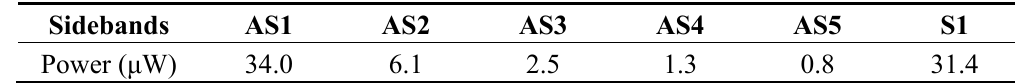
Table 2. Output power of AS1-AS5 and S1 with average power of 0.855 mW and 0.856 mW for Beam 1 and Beam 2, respectively